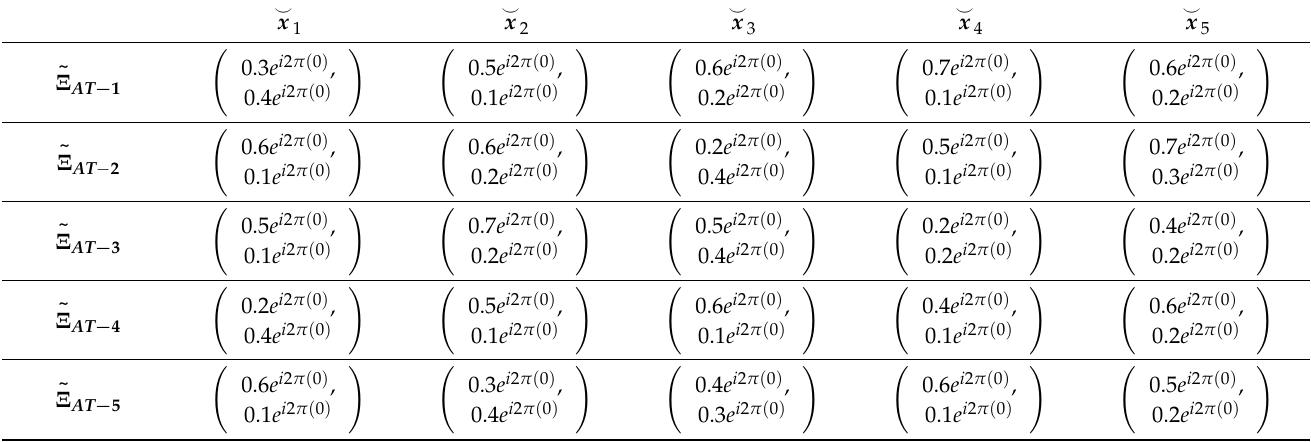
Table 8. Original decision matrix for candidates 𝛯(cid:3560) (cid:3004)(cid:3010)(cid:2879)(cid:2870) .